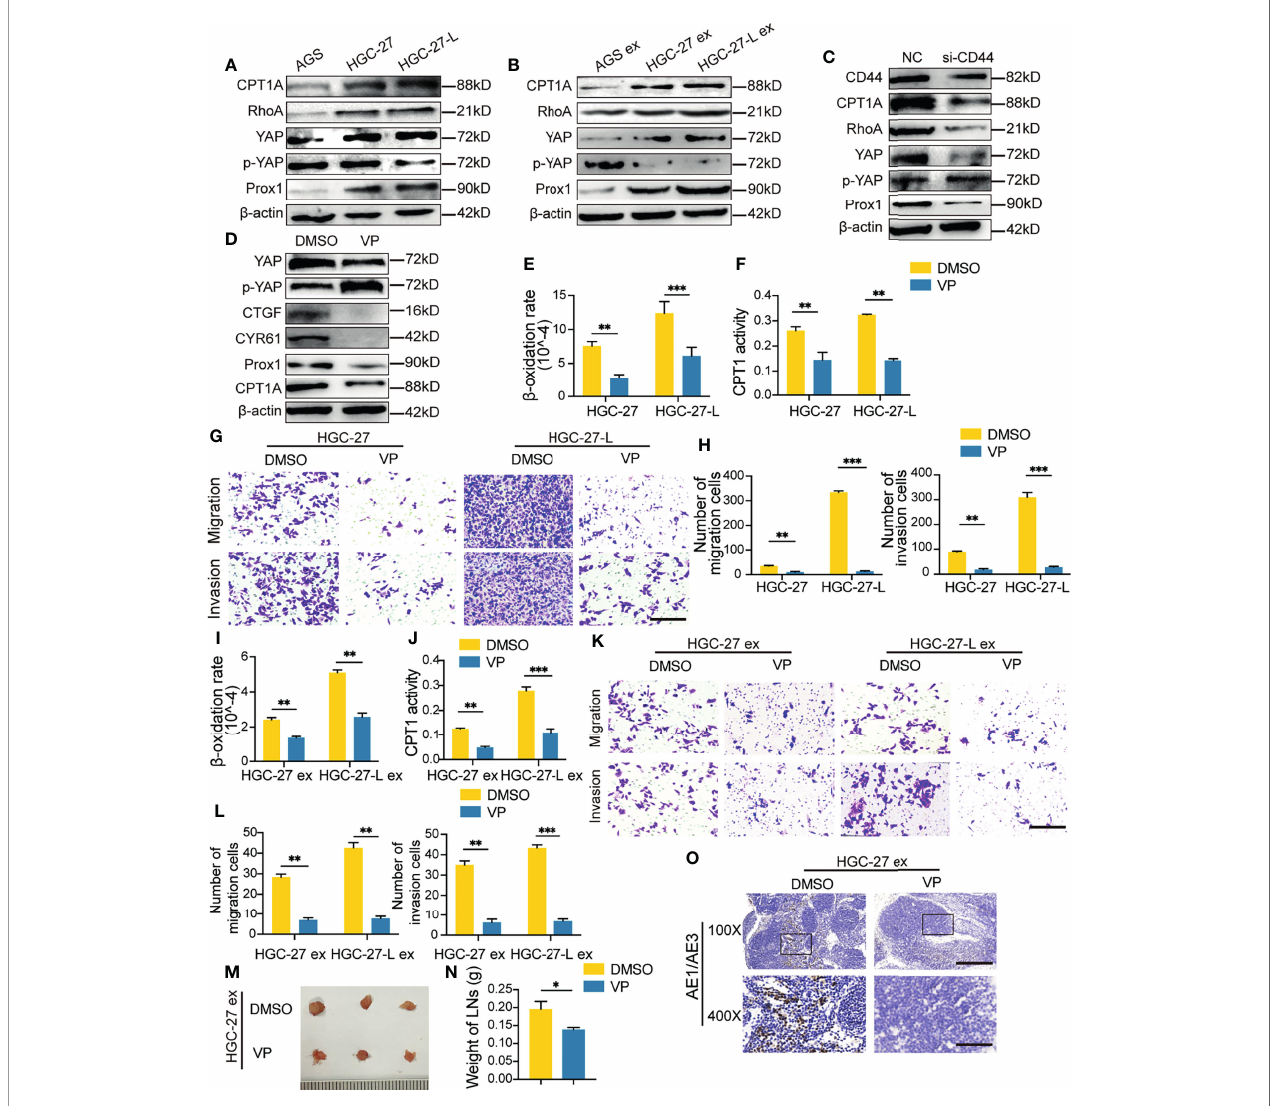
FIGURE 5 | Exosomal CD44 increased FAO possibly via regulating the RhoA/YAP/Prox1/CPT1A signaling axis (A – C) Western blotting of CPT1A, RhoA, YAP, phosphorylated-YAP (p-YAP) and Prox1 in GC cells (A) , exosome-treated AGS (B) and si-CD44-transfected HGC-27 (C) ; (D) Protein analysis in Vertepor fi n (VP) treated HGC-27; (E – H) Effect of VP treatment on FAO (E, F) , migration and invasion capacity (G, H) of HGC-27 and HGC-27-L cells; (I – L) Effect of VP pretreatment on lymphatic GC cell-exosomes increasing FAO (I, J) , migration and invasion capacity (K, L) of AGS; (M – O) Effect of VP pretreatment on HGC-27-exosome enhancing LNM capacity of AGS in vivo . Ruler unit, mm. ex, exosomes. * P < 0.05; ** P < 0.01; *** P <